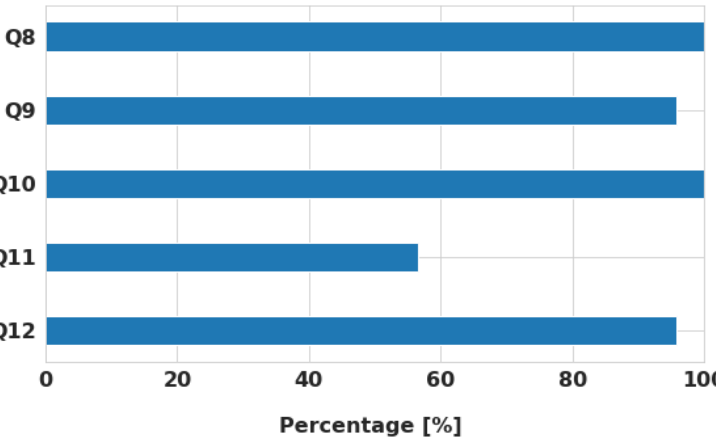
Figure 8. Positive responses to survey questions Q8, Q9, Q10, Q11 and